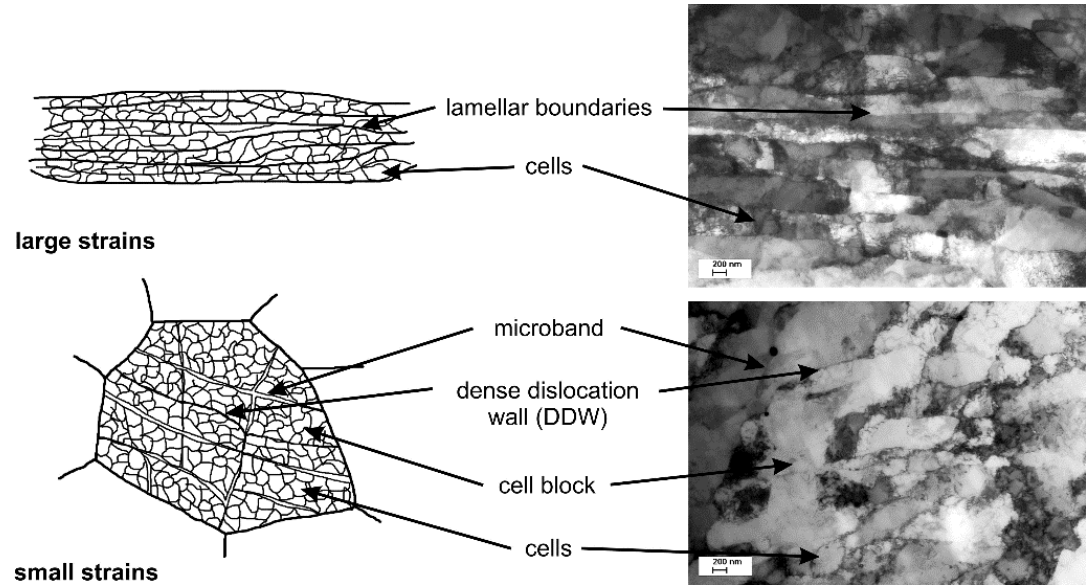
Figure 8. Schematic representation of the deformation microstructure and grain subdivision at different strains (large/small) and corresponding STEM-micrographs of the investigated aluminum alloy